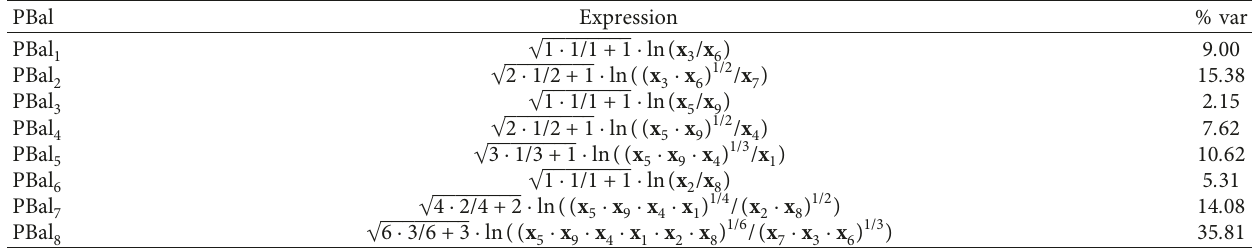
Table 1: The expression of the principal balances and their percentage of variance.